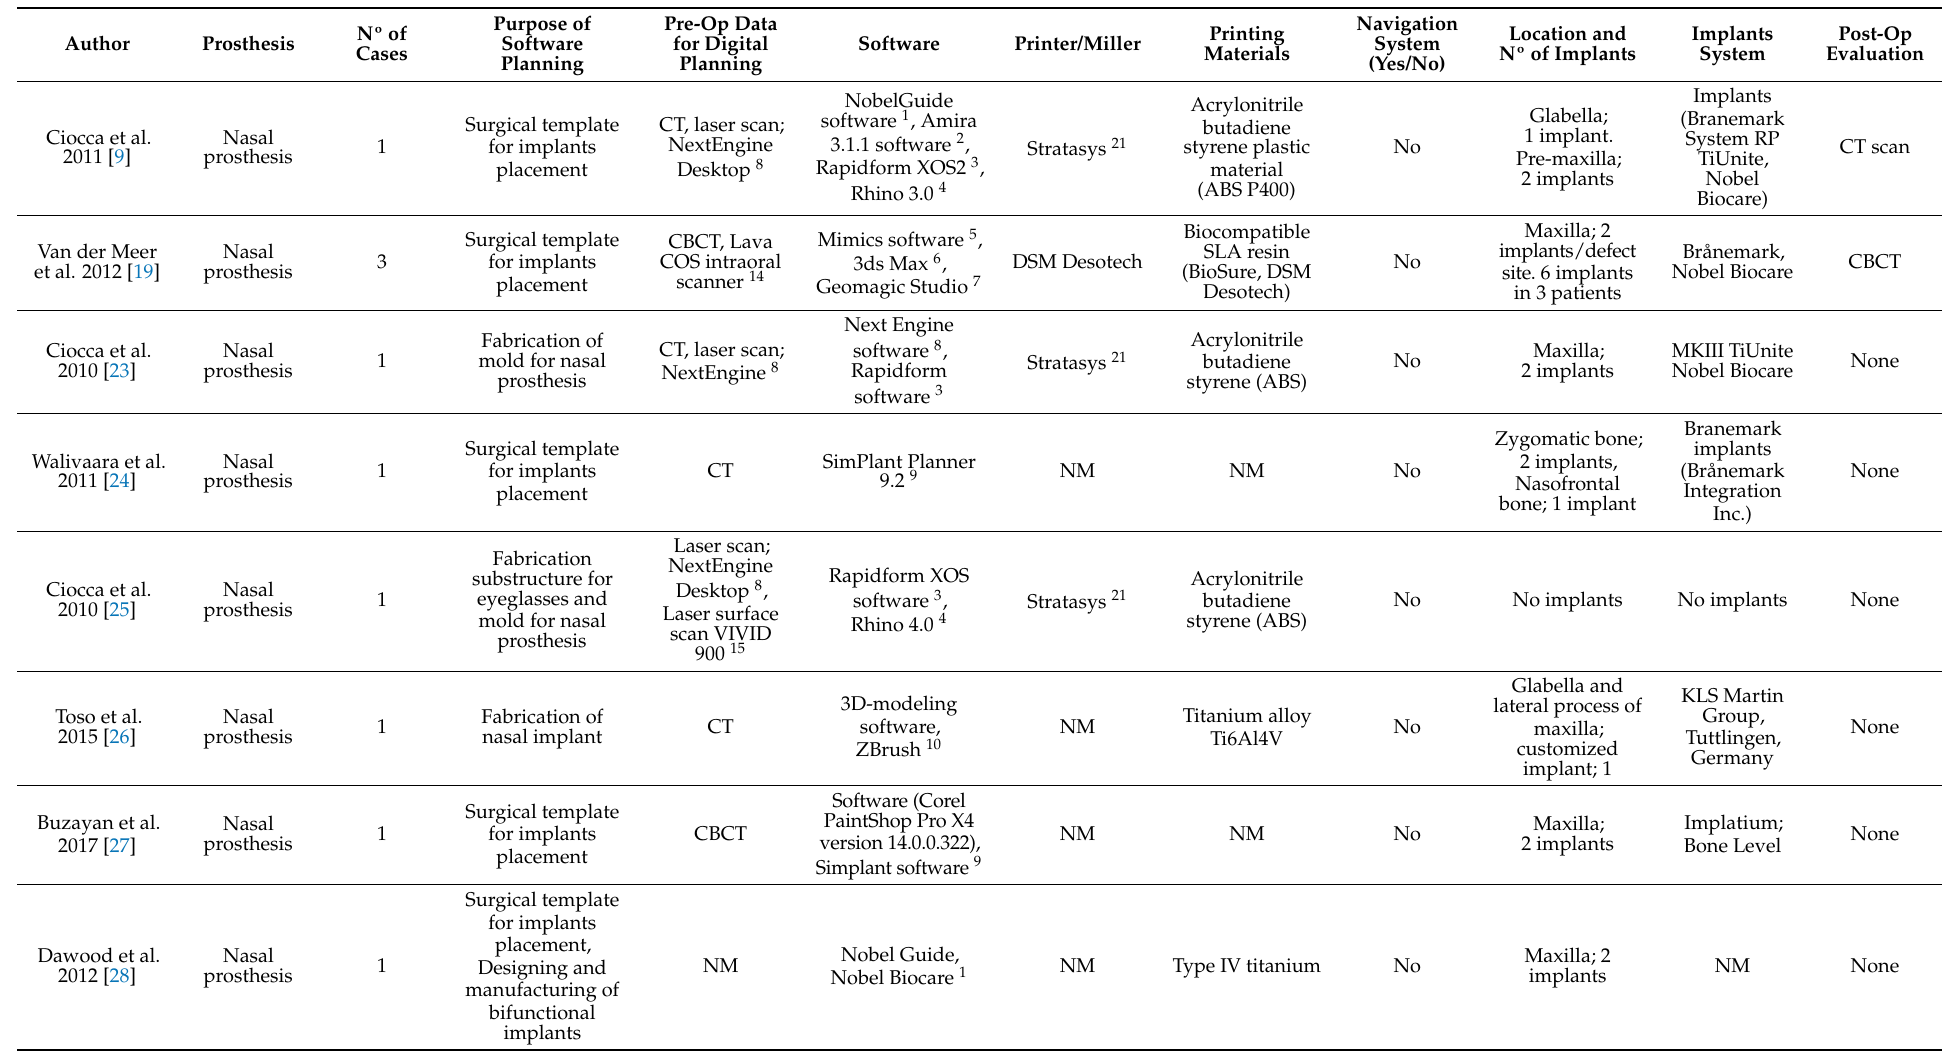
Table 1. Digital planning for craniofacial implants placement and fabrication of nasal